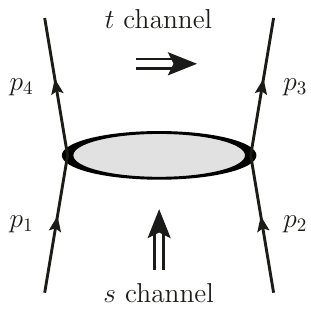
Figure 1 . The t -channel exchange dominating the high-energy limit, s (cid:29) (cid:0) t > 0. The (cid:12)gure also de(cid:12)nes our conventions for momenta assignment and Mandelstam invariants. We shall assume that particles 2 and 3 (1 and 4) are of the same type and have the same